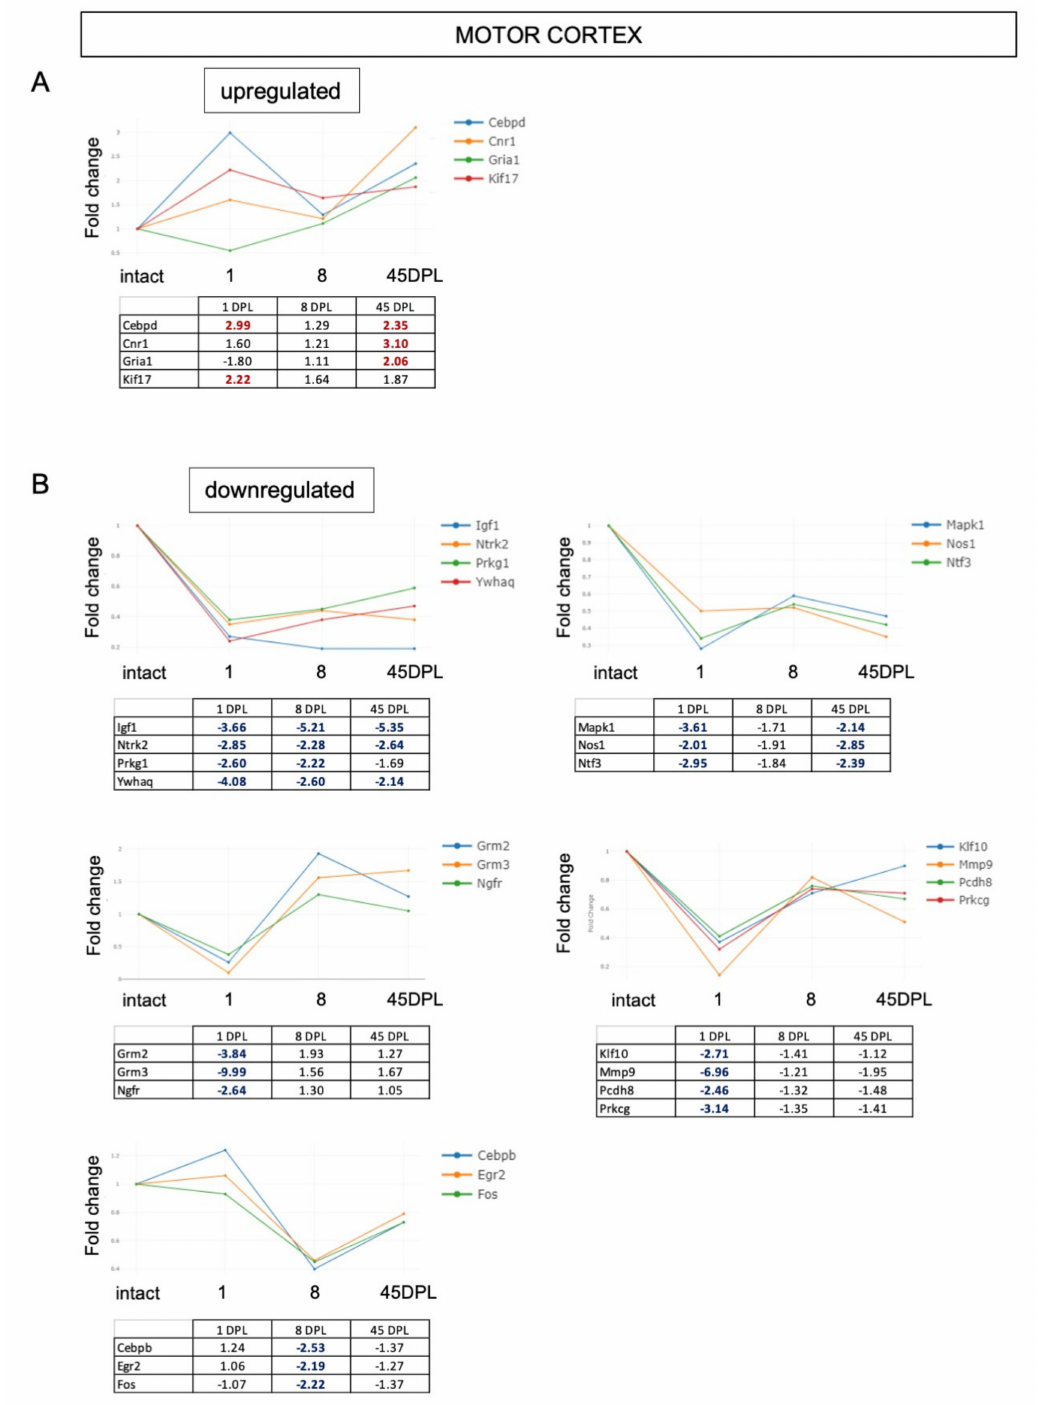
Figure 4. ( A , B ) Time course expression of upregulated ( A ) and downregulated ( B ) genes in motor cortex. Relative gene expression is shown as Fold Change (FC) normalized on motor cortex from intact animals. Only genes with FC ≥ 2 are included in the